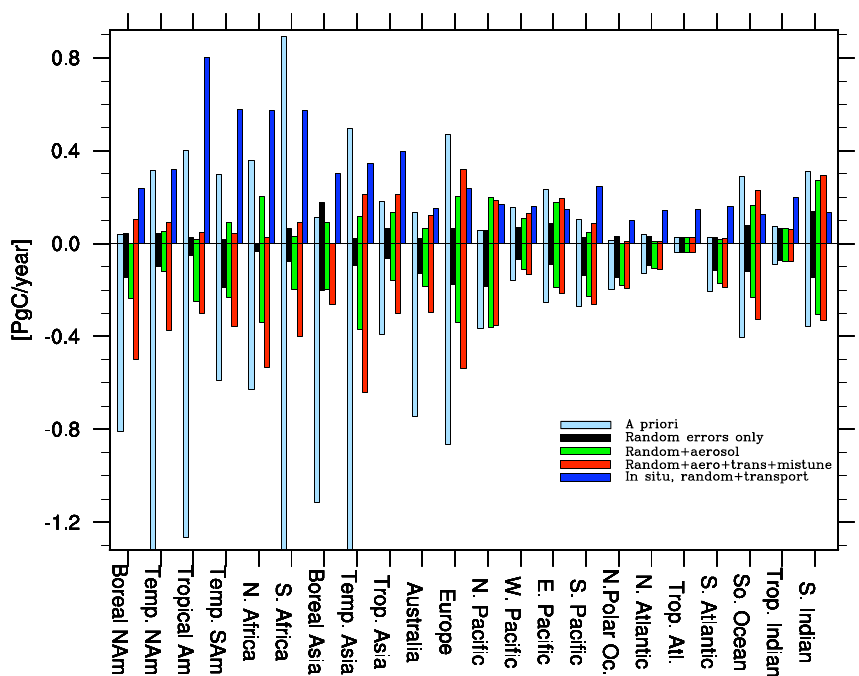
Fig. 10. Annual mean flux errors and RMS seasonal flux errors [PgC/year] integrated over the areas of the 22 Transcom3 emission regions. The absolute values of the annual mean errors are plotted above the axis as positive values, while the RMS of four 13-week seasonal values are plotted below it as negative values. A posteriori errors from three glint mode experiments are given: #2 (black bars), in which only random measurement errors are added, #4 (green) in which aerosol biases are also added, and #6 (red) in which random errors, aerosol bias, and transport errors are all added, as well as mistuning effects. Also given: the a priori flux errors (light blue) and the a posteriori errors given by assimilating only data from the in situ CO 2 montoring network of the 1990s (dark blue), computed as the root sum square of the “Post. Error” and “Model Error” columns from Table 4 of the Transcom3 CO 2 flux interannual variability study (Baker et al.,